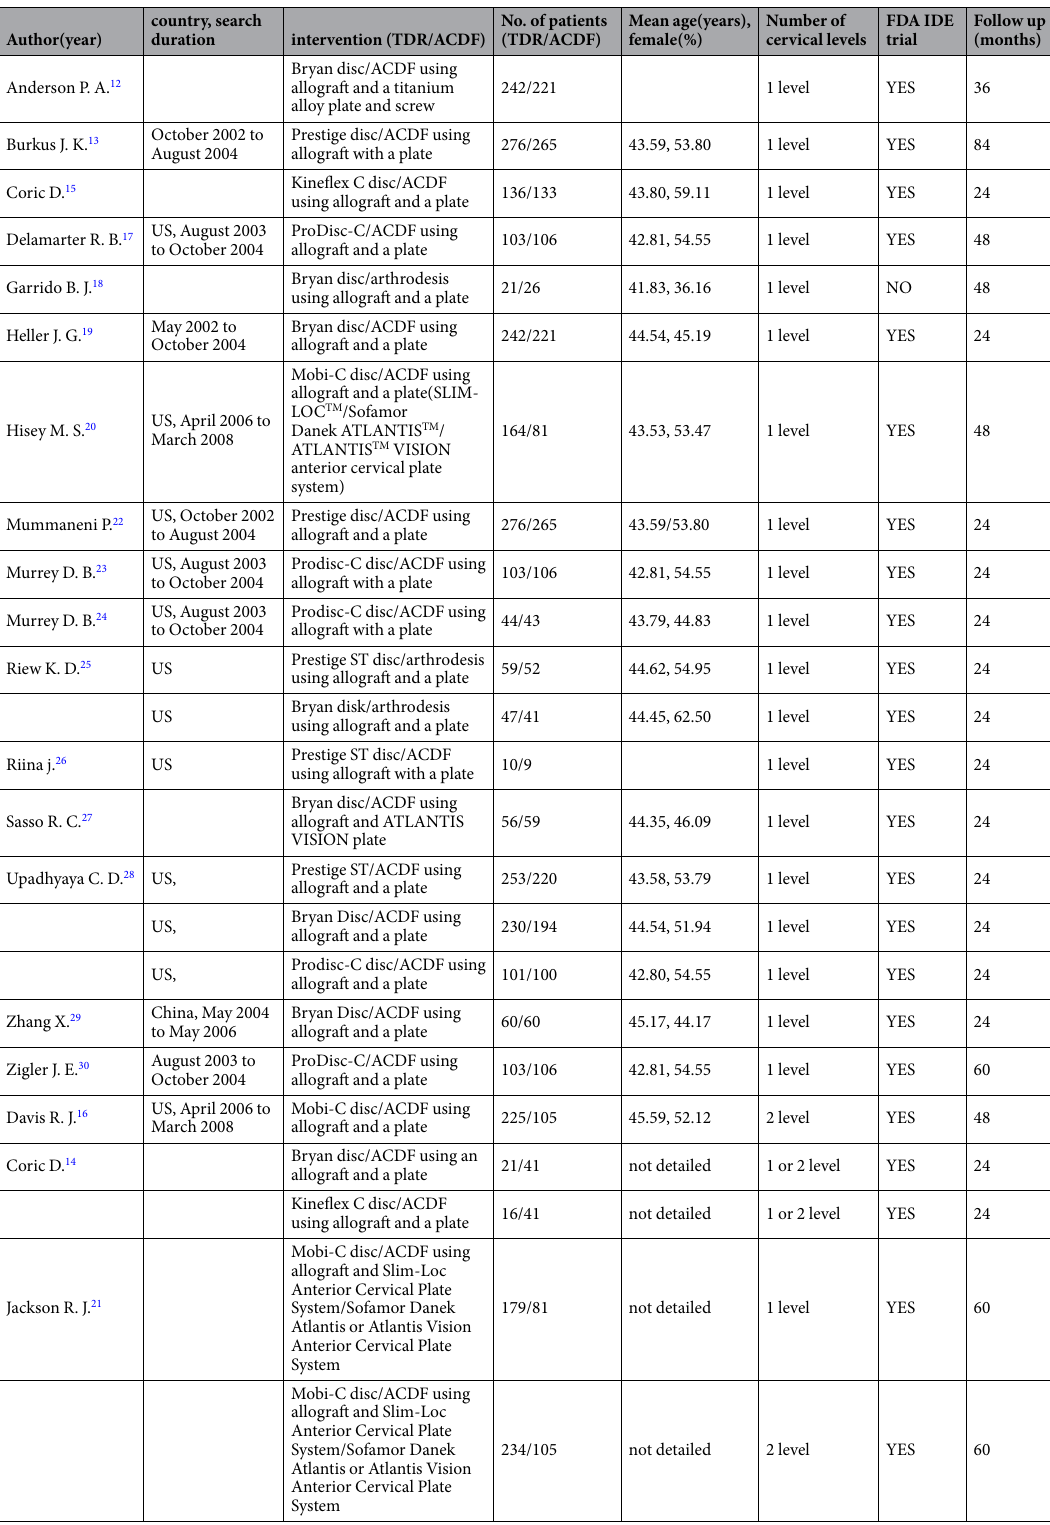
Table 1. Basic characteristics of patients included in the meta-analysis. FDA IDE trial: Food-and-Drug- Administration-regulated Investigational Device Exemption